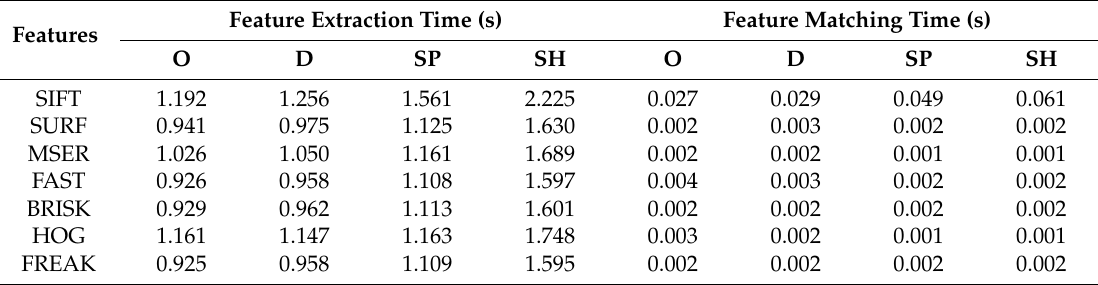
Table 2. Feature extraction and matching